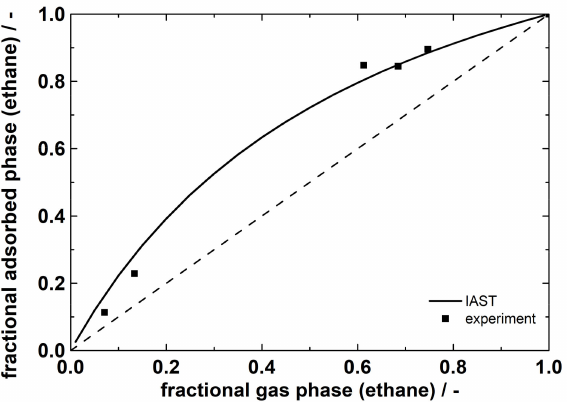
Figure 3. Mixed adsorption equilibria at 20 ◦ C in ZIF-4 for ethane/ethene at a total pressure of 100 kPa. Lines: calculated data by IAST (using Toth).